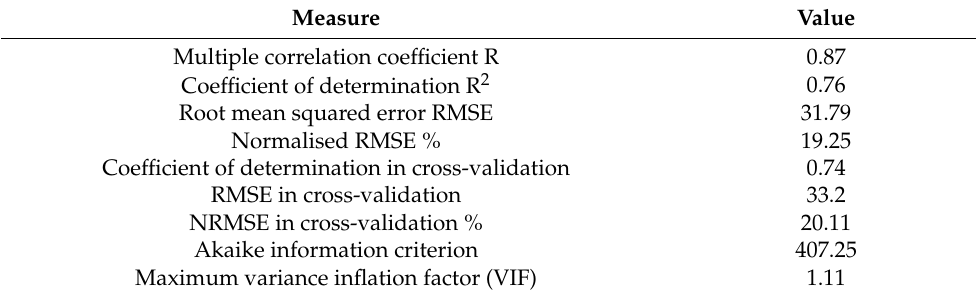
Table 3. Statistical characteristics of the model for surface temperature